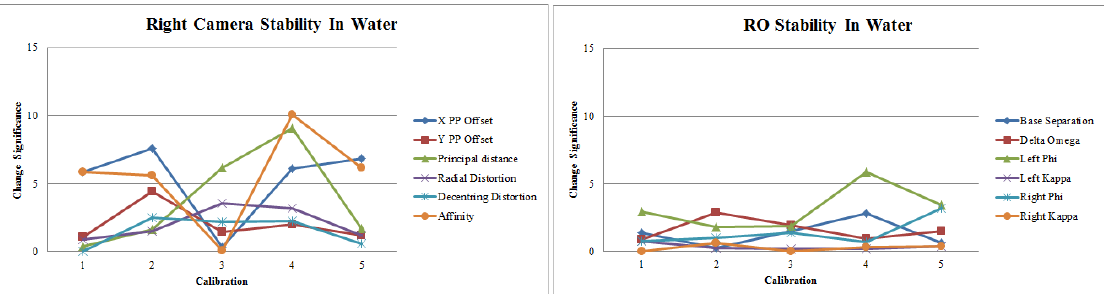
Figure 8. Stability of the right camera calibration parameters ( Left ) and the relative orientation parameters ( Right ) for a GoPro Hero 2 stereo-video system. The vertical axis is the change significance of individual parameters between consecutive calibrations [73].